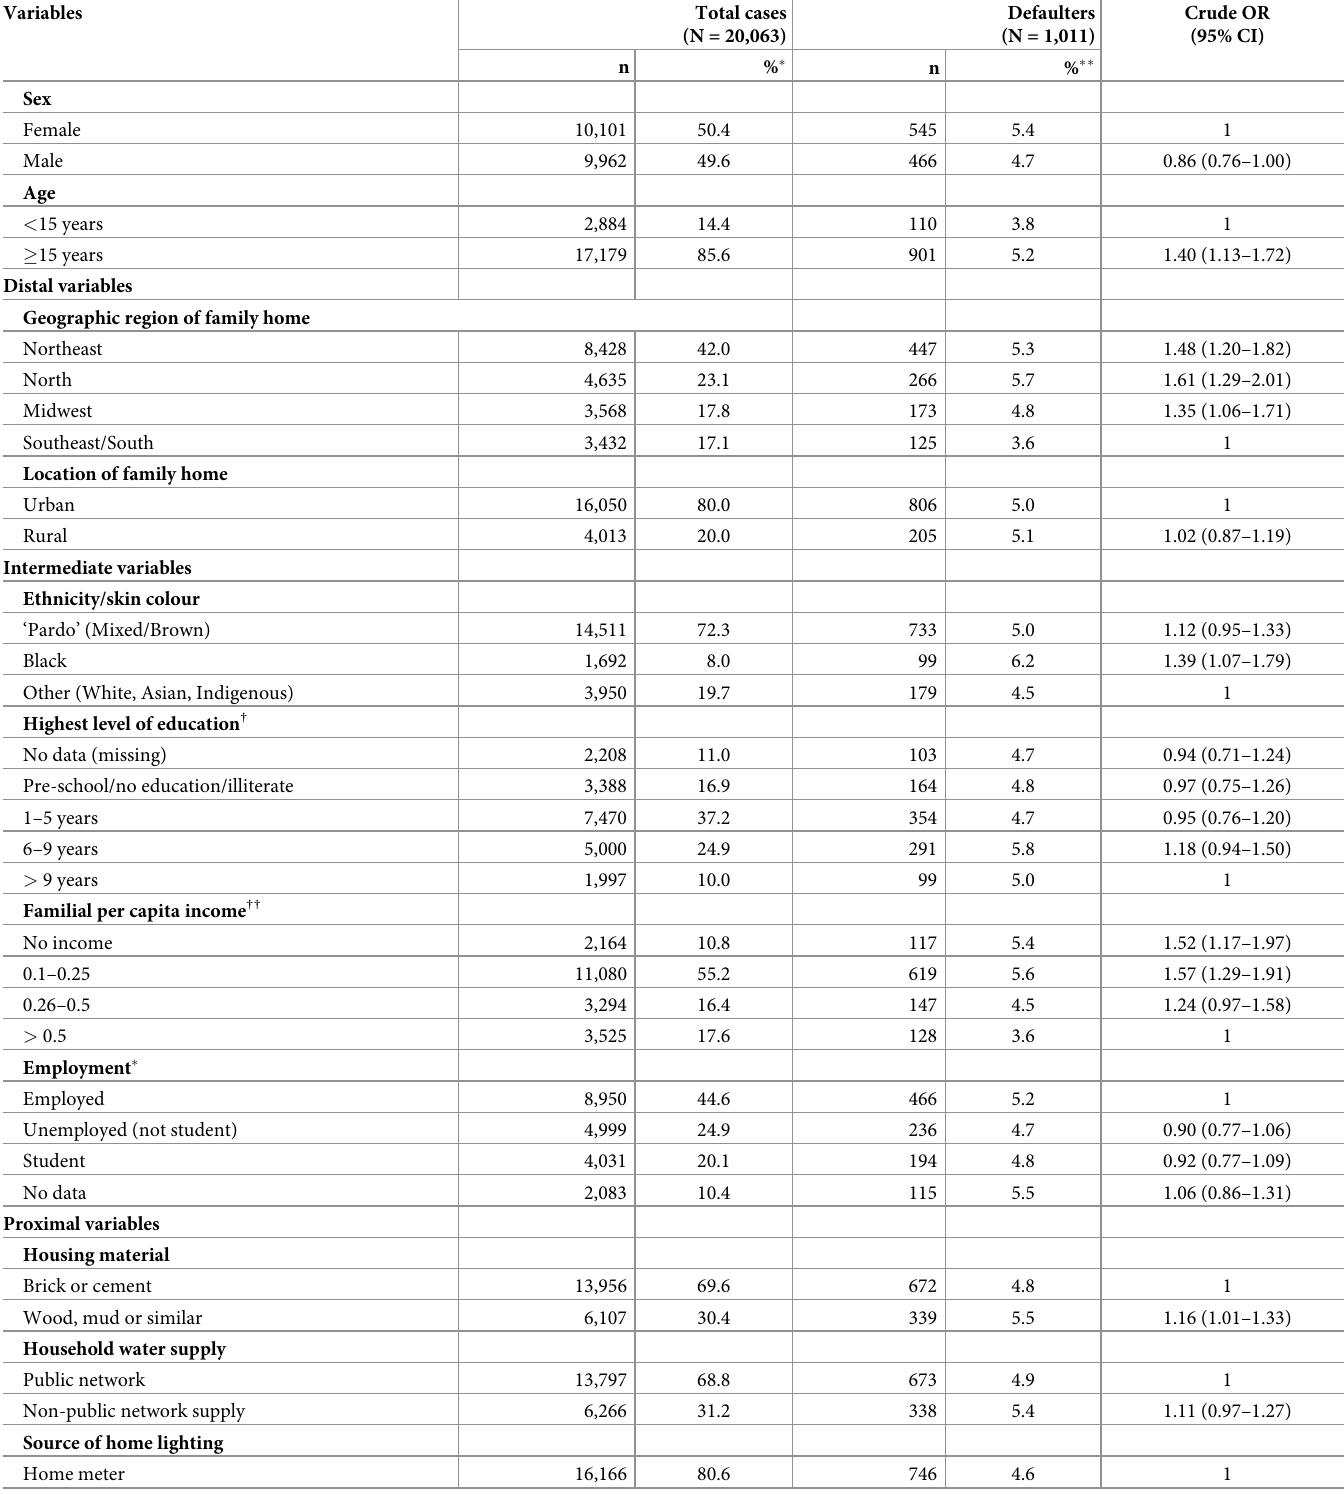
Table 1. Proportion of new leprosy cases (N = 20,063), proportion of defaulters in each subgroup and bivariate associations of geographic and socioeconomic fac- tors with leprosy treatment default, Brazil,